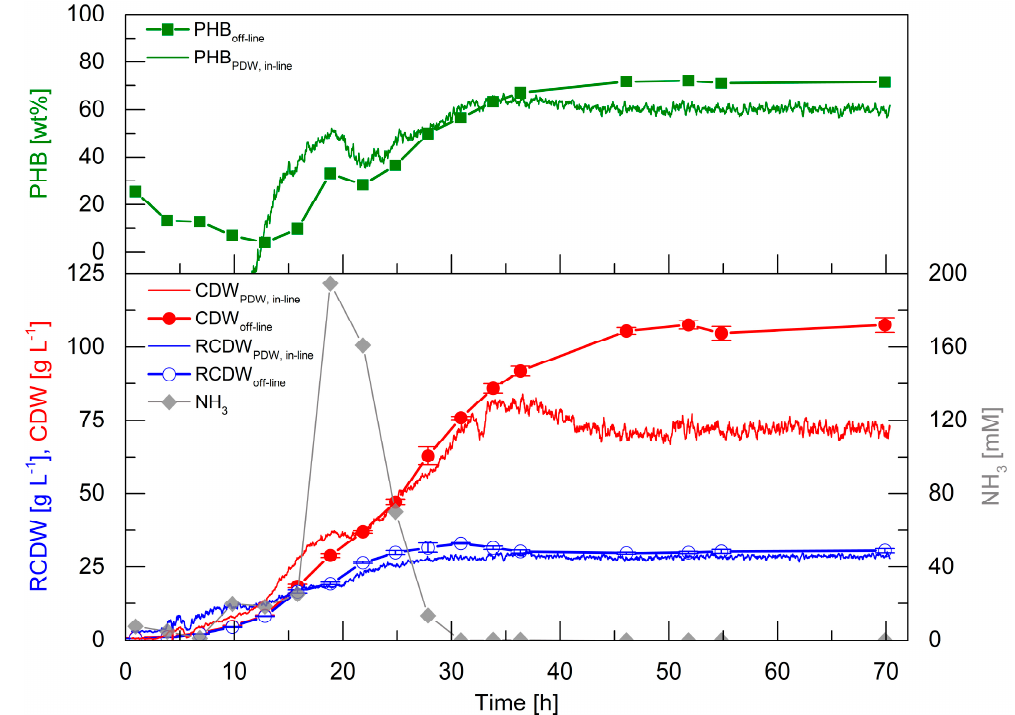
Figure 5. Fed-batch cultivation of R. eutropha H16 for PHB production. The culture was started with 4% (w·v − 1 ) rapeseed oil and 4.5 g·L − 1 urea (150 mM nitrogen). Rapeseed oil feeding linearly increased from 7 h with an initial feeding rate of 3.5 g·h − 1 to 35 h with a final feeding rate of 23 g·h − 1 up to a total concentration of 17% (w·v − 1 ). Urea (30% (w·v − 1 )) feeding was linearly increased from 7 h with an initial feeding rate of 0.39 mL·h − 1 up to a final feeding rate of 6.58 mL·h − 1 at 16 h to a total concentration of 14.4 g·L − 1 . In-line PHB content (upper graph, green line, wt%) by PDW spectroscopy and off-line PHB content (upper graph, green squares, wt%), estimated in-line CDW by PDW spectroscopy (bottom graph, red line, g·L − 1 ), off-line CDW (bottom graph, red filled circles, g·L − 1 ), estimated in-line RCDW by PDW spectroscopy (bottom graph, blue line, g·L − 1 ), off-line RCDW (bottom graph, blue empty circles, g·L − 1 ), and ammonia content (bottom graph, grey diamonds, mM) are shown. Error bars indicate minimum and maximum values of technical duplicates.